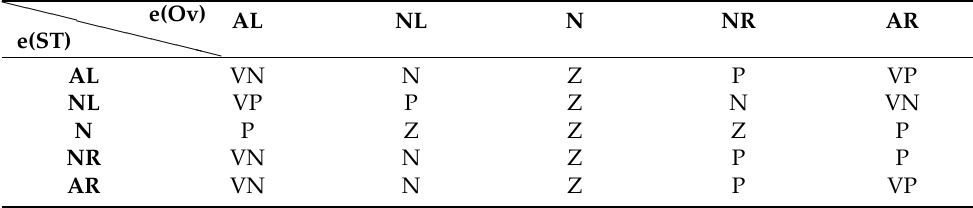
Table 2. Fuzzy rule matrix for variable b (cid:48)